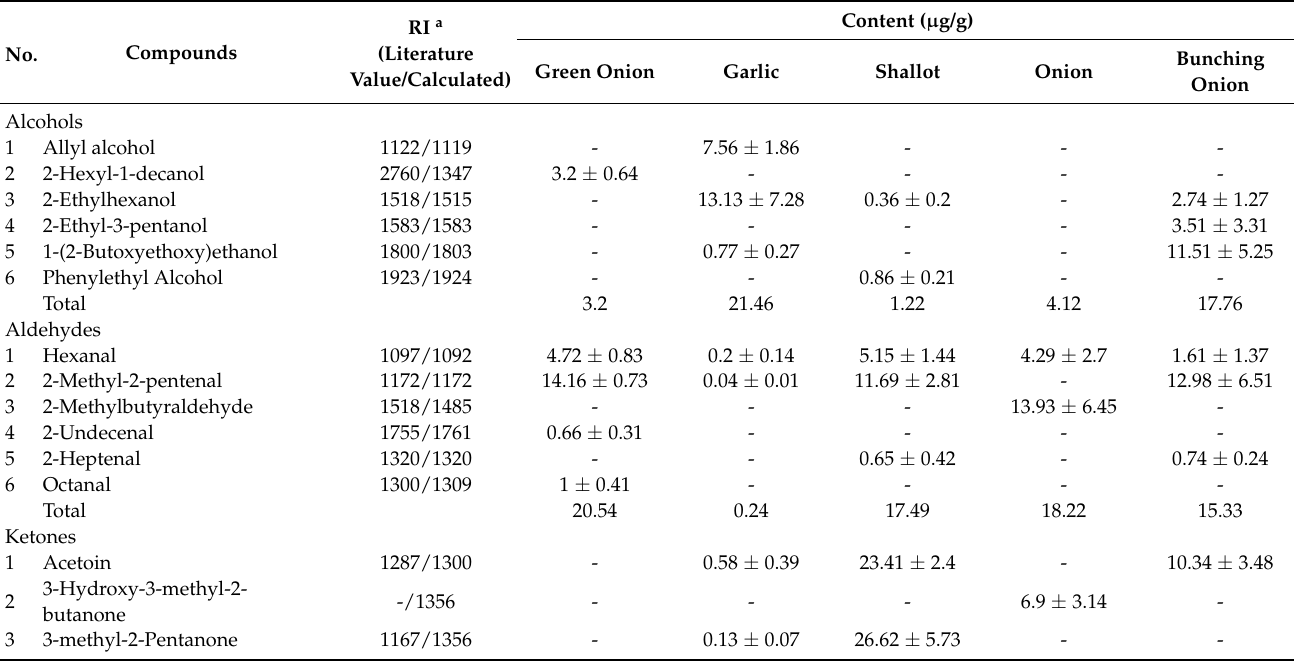
Table A3. Comparative analysis of the volatile compounds detected in five fresh Allium plants by gas chromatography-mass spectrometry